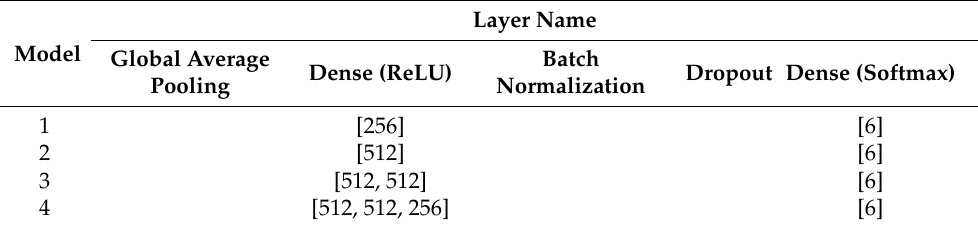
Table 1. Structure of the classifier blocks tested in this study. Brackets show the number of the dense layers and their neurons.